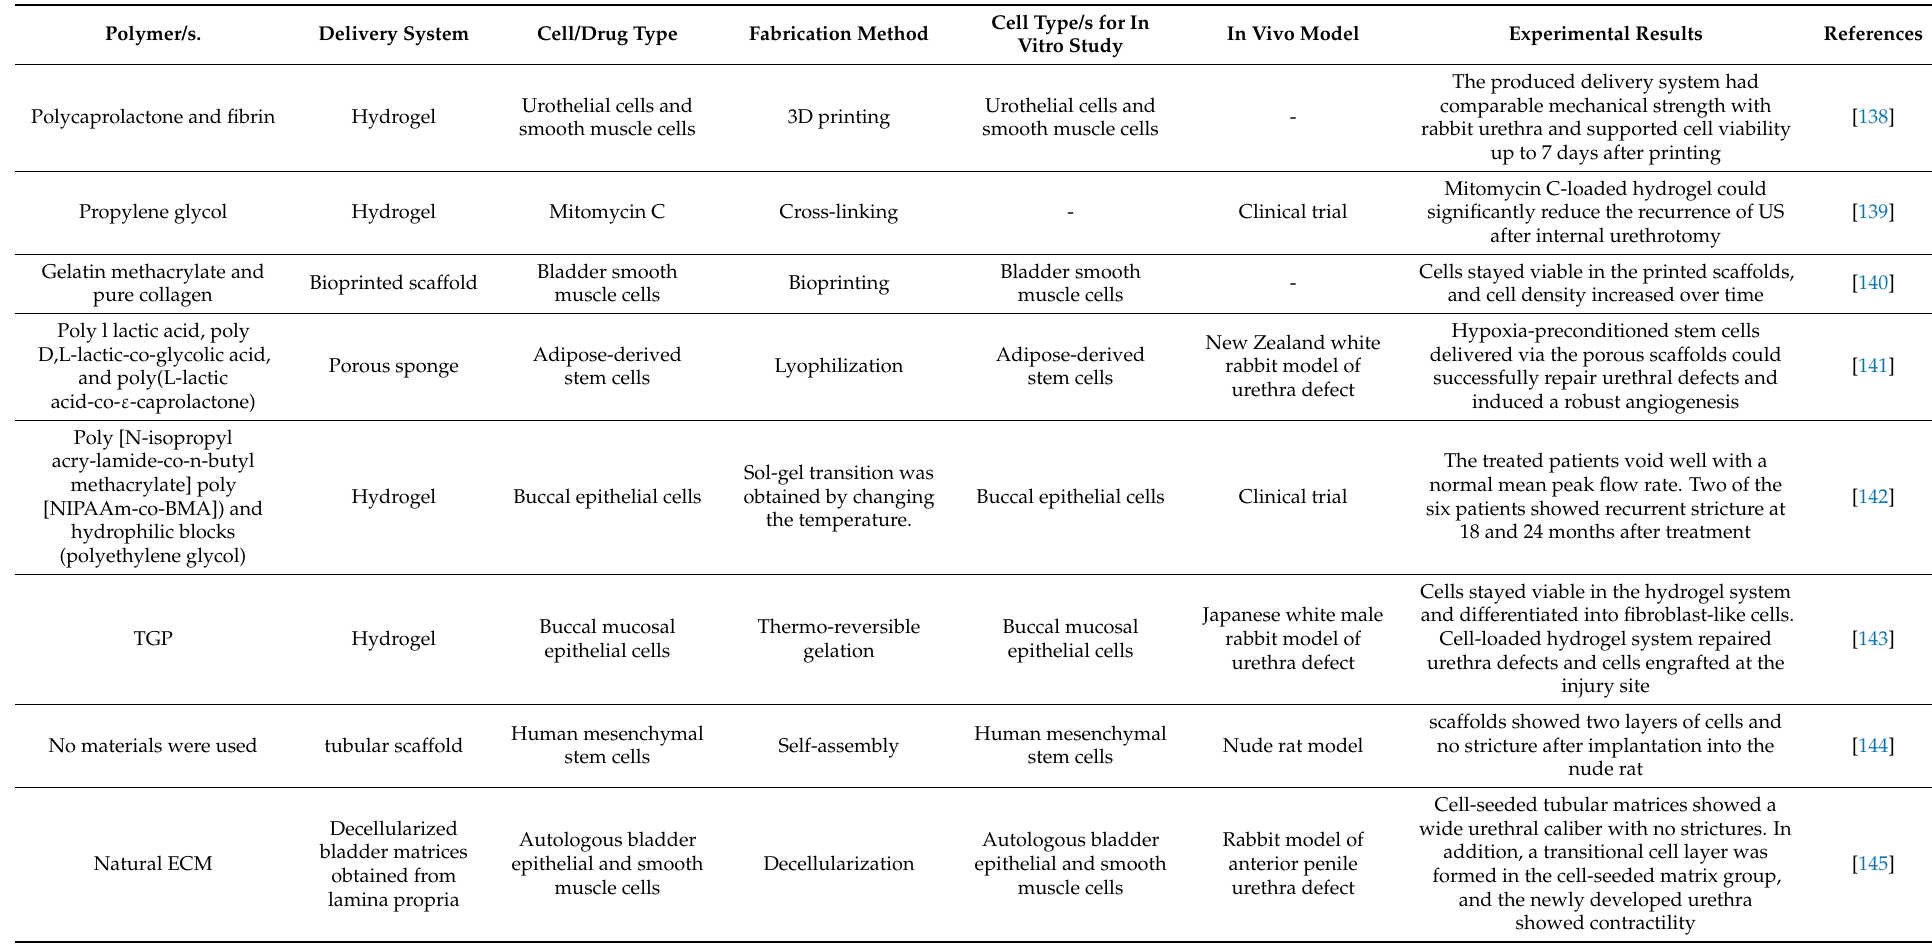
Table 1. Summary of previous applications of cell and drug delivery systems to treat urethra